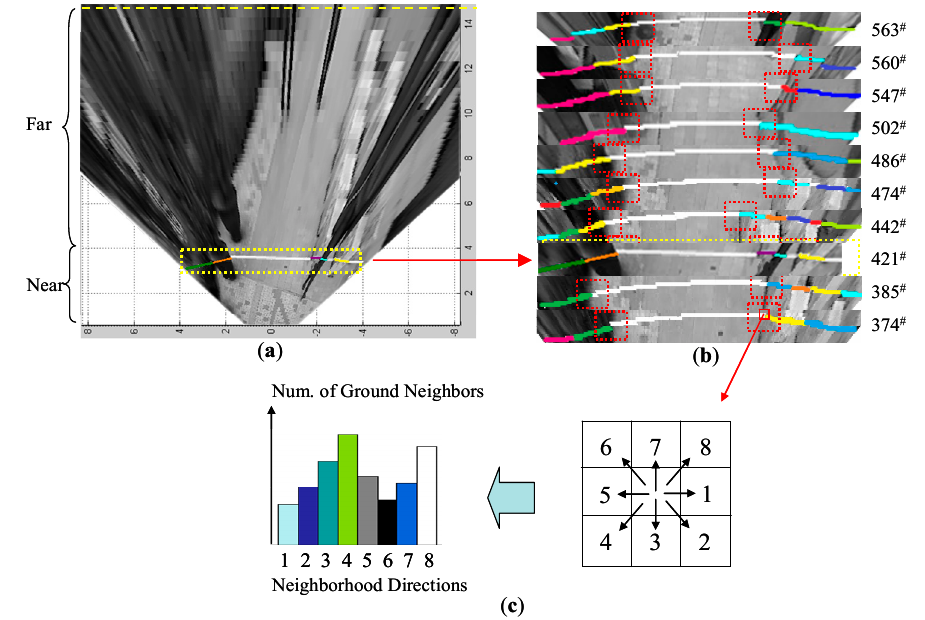
Figure 10. Learning spatial distribution properties from near-field labelled data. ( a ) Near-field ROI